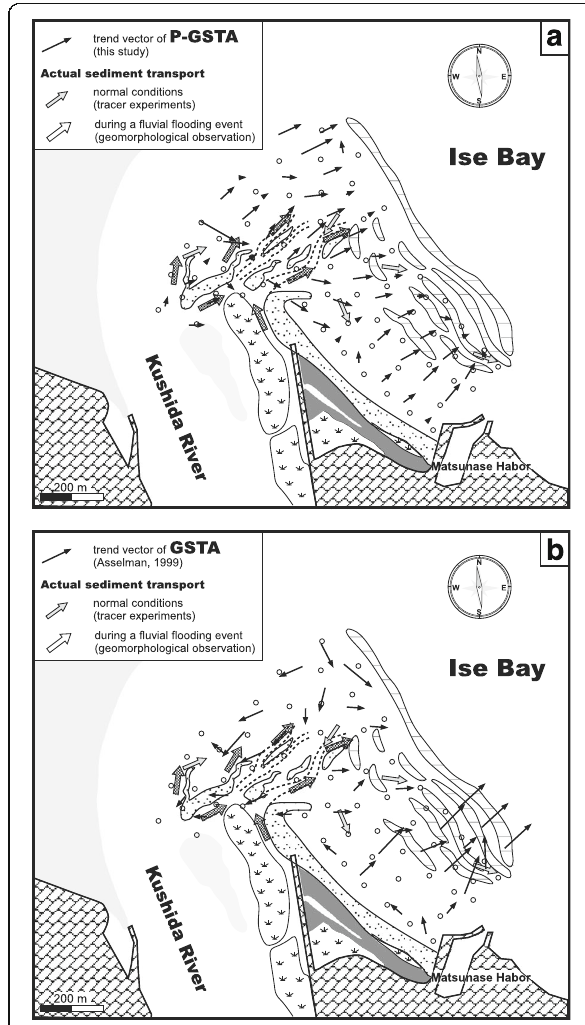
Fig. 12 Grain-size trend vectors. The actual sediment-transport directions during normal conditions are shown as the mean direction of tracer results (see Fig. 4a). Circles indicate the sampling points. a Grain-size trend vectors calculated by P-GSTA. b Grain-size trend vectors calculated by the previous GSTA method (Asselman 1999). Some of sampling points lack the trend vector because the GSTA method does not recognize the grain-size trend when no surrounded locations satisfy the conditions FB − or